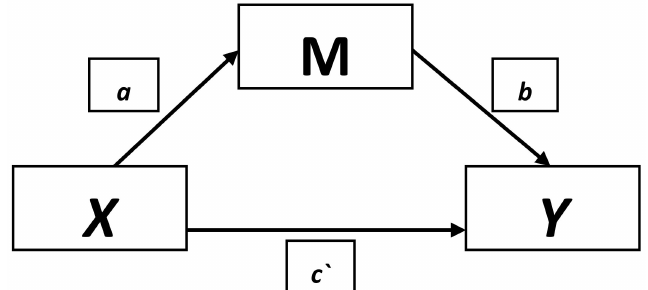
Figure 1. Model presenting the examined mediation effect. X, independent variable (protein concentration); M, mediator; Y, dependent variable (GDS-SF); a, association between X and M; b, association between M and Y after controlling for X; c‘, direct